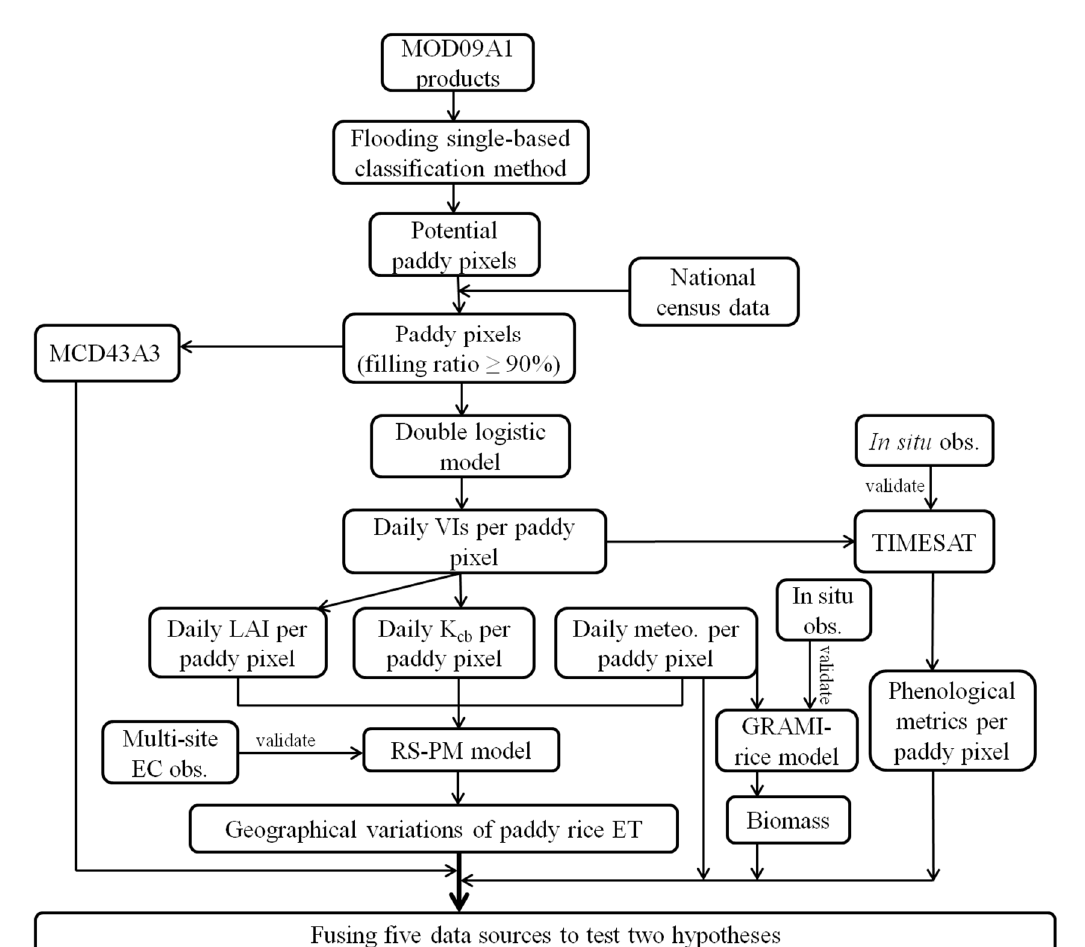
Figure 1. The schematic route of earth observations and numerical simulations to evaluate two hypotheses through correlation analysis among geographical variations of ET , T s , and biophysical factors. meteo.: daily meteorological variables of ground surface [i.e., daily incident solar radiation (MJ m –2 day –1 ), daily maximum and minimum air temperatures (°C), relative humidity (%), and wind speed grid data (m s –1 )]; VI s: vegetation indices; LAI : leaf area index (m 2 m –2 ); K cb : transpiration coefficient; ET : evapotranspiration (mm m –2 day –1 ); EC : eddy covariance system; obs.: field observations.